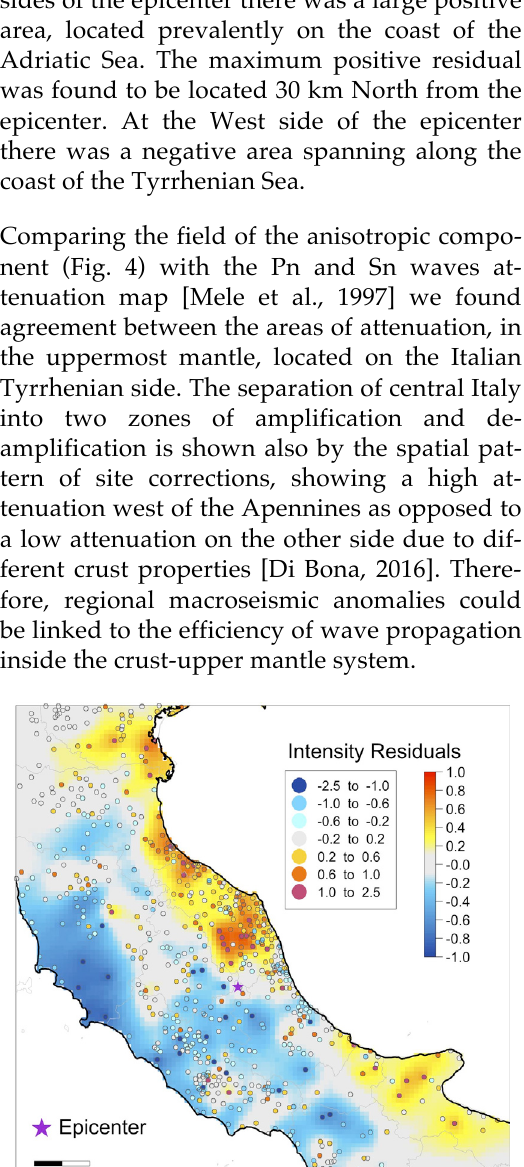
) (coloured shaded ar- A